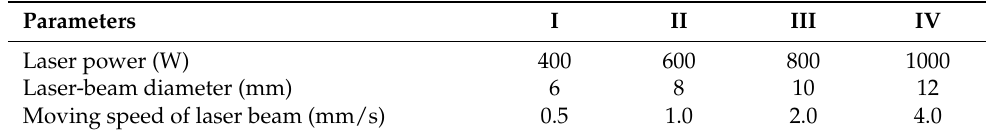
Table 1. Experimental scheme.